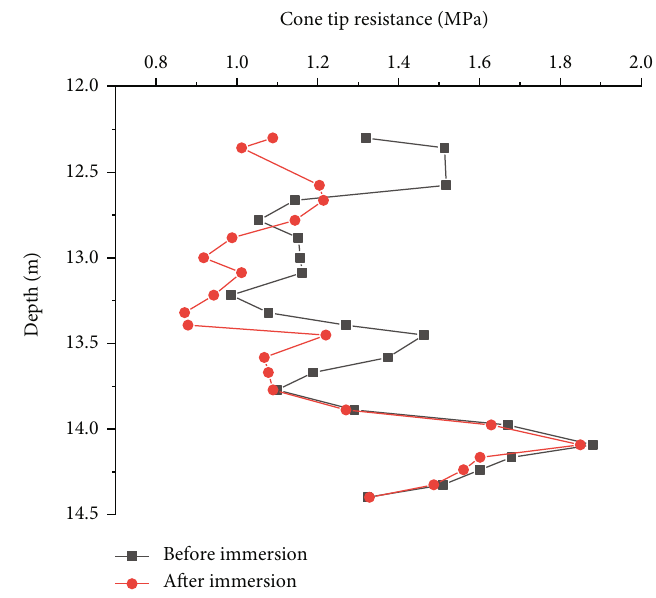
− h curve of middle section of pipe gallery foundation before and after Figure 6: Static cone penetration q c